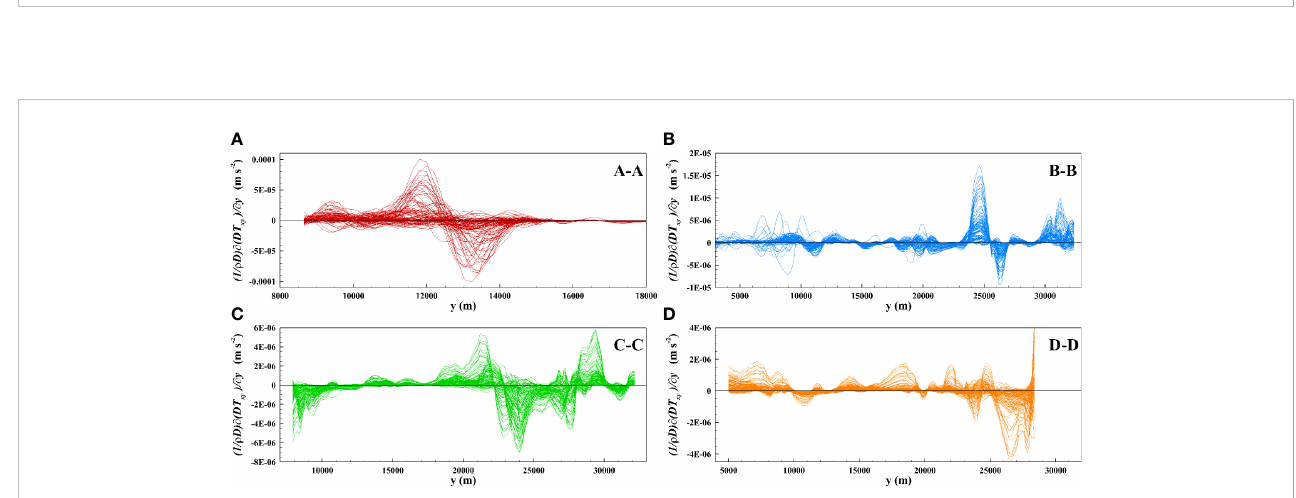
Four panels showing the distribution of the transverse shear stress 1 = ( r D )( ∂ D (cid:1)T xy ) = ( ∂ y ) with time: (A) section AA, (B) section BB, (C) section CC, and (D) section DD.